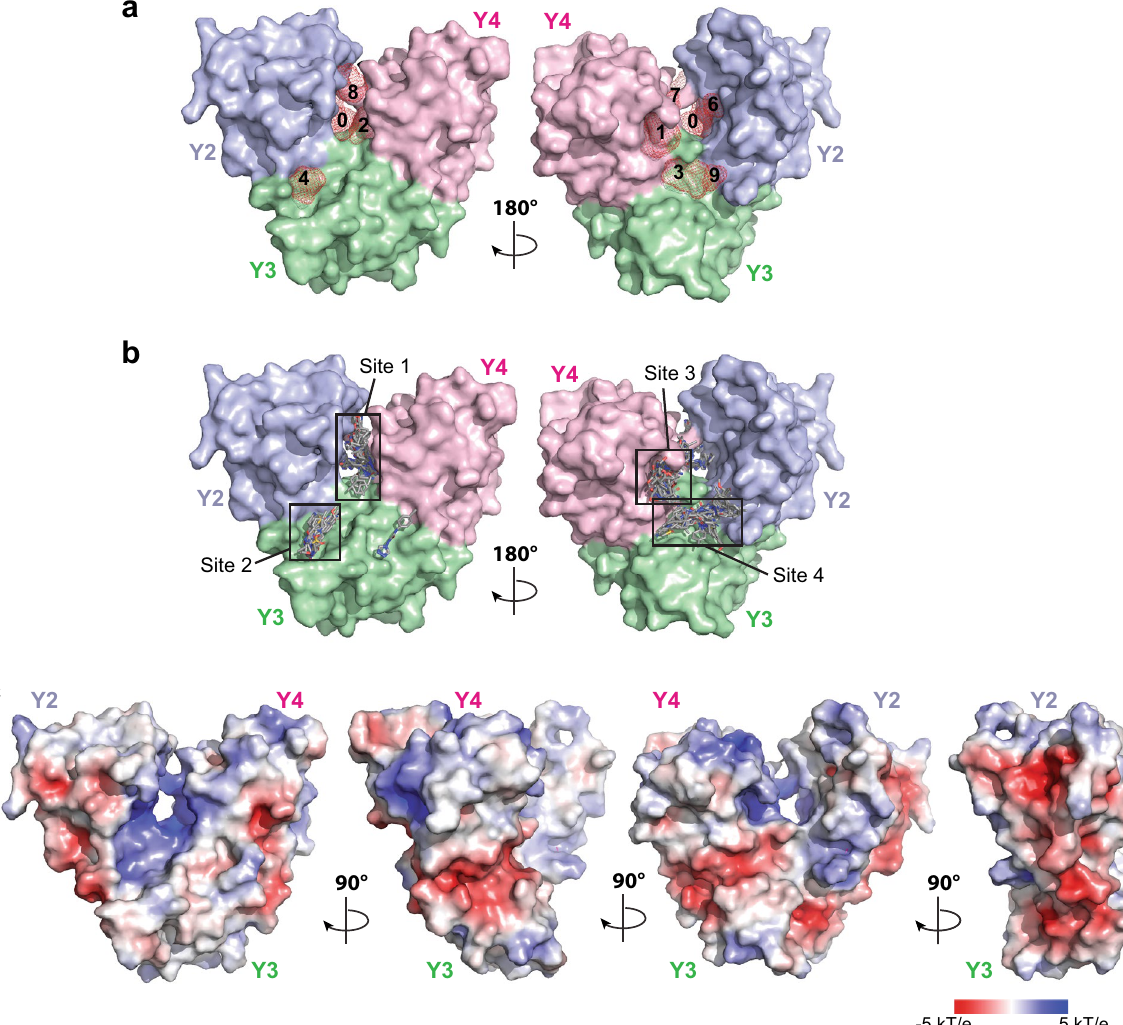
Figure 5. Molecular docking of the NMR-identified binders onto the structure of CoV-Y. ( a ) Molecular surface of CoV-Y showing the ten surface cavities identified using the FTMap server (https:// ftmap. bu. edu). ( b ) Molecular docking of the 17 binders identified by NMR fragment-screening onto the CoV-Y structure by AutoDock Vina 57 . The top-ranked docking pose of each binder is shown in stick representation in four sites overlapped with those identified by FTMap. Chemical structure of each binder and the estimated binding energy of their top docking poses are listed in Supplementary Table S3. ( c ) Molecular surface representation of CoV-Y, colored according to the local electrostatic potential ranging from − 5 kT/e in deep red (most negative) to 5 kT/e in dark blue (most positive), calculated using the program ABPS 59